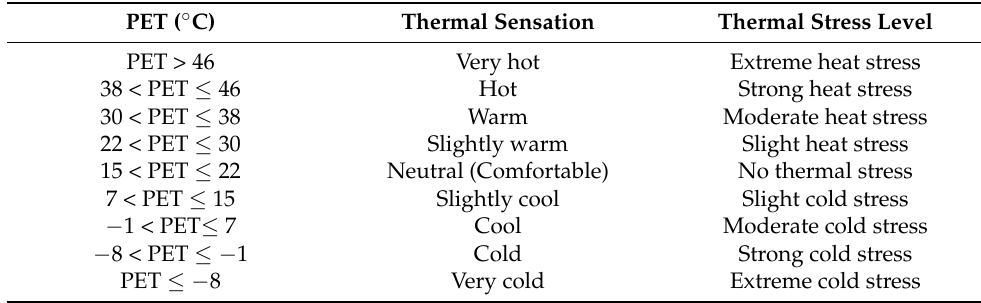
Table 5. Modified PET classification for areas with hot summers and cold